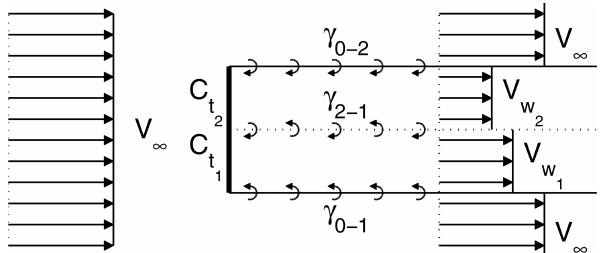
Figure 6. Schematic view of a non-uniformly loaded disc in a uni- form